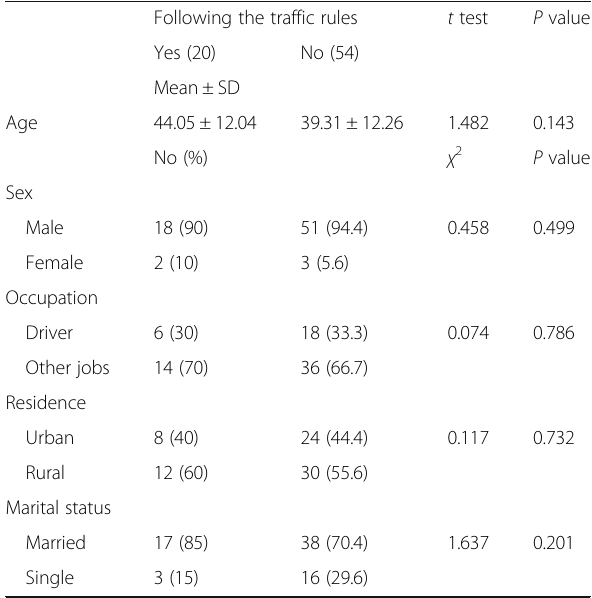
Table 3 Descriptive data and degree of following the traffic rules